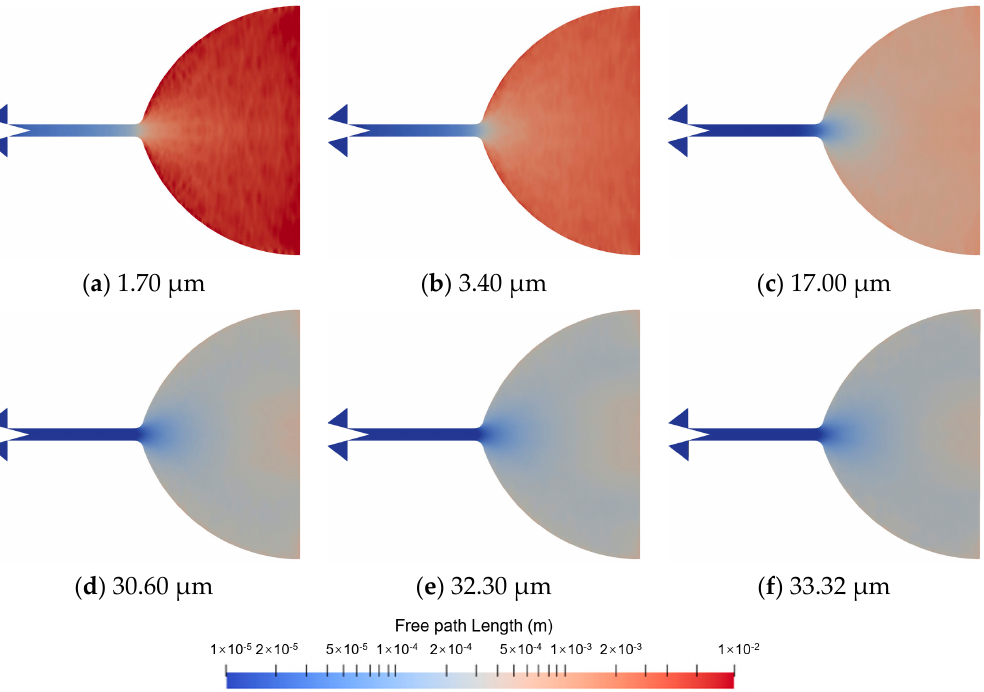
Figure 12. Local mean molecular free path length in the axial plane with different needle displace- ments at t = 0.1